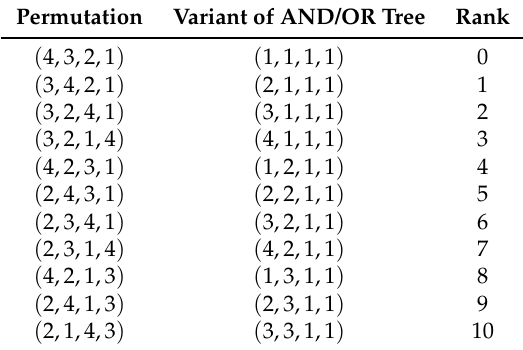
Table A4. Ranking the combinatorial set of permutations of n elements for n =